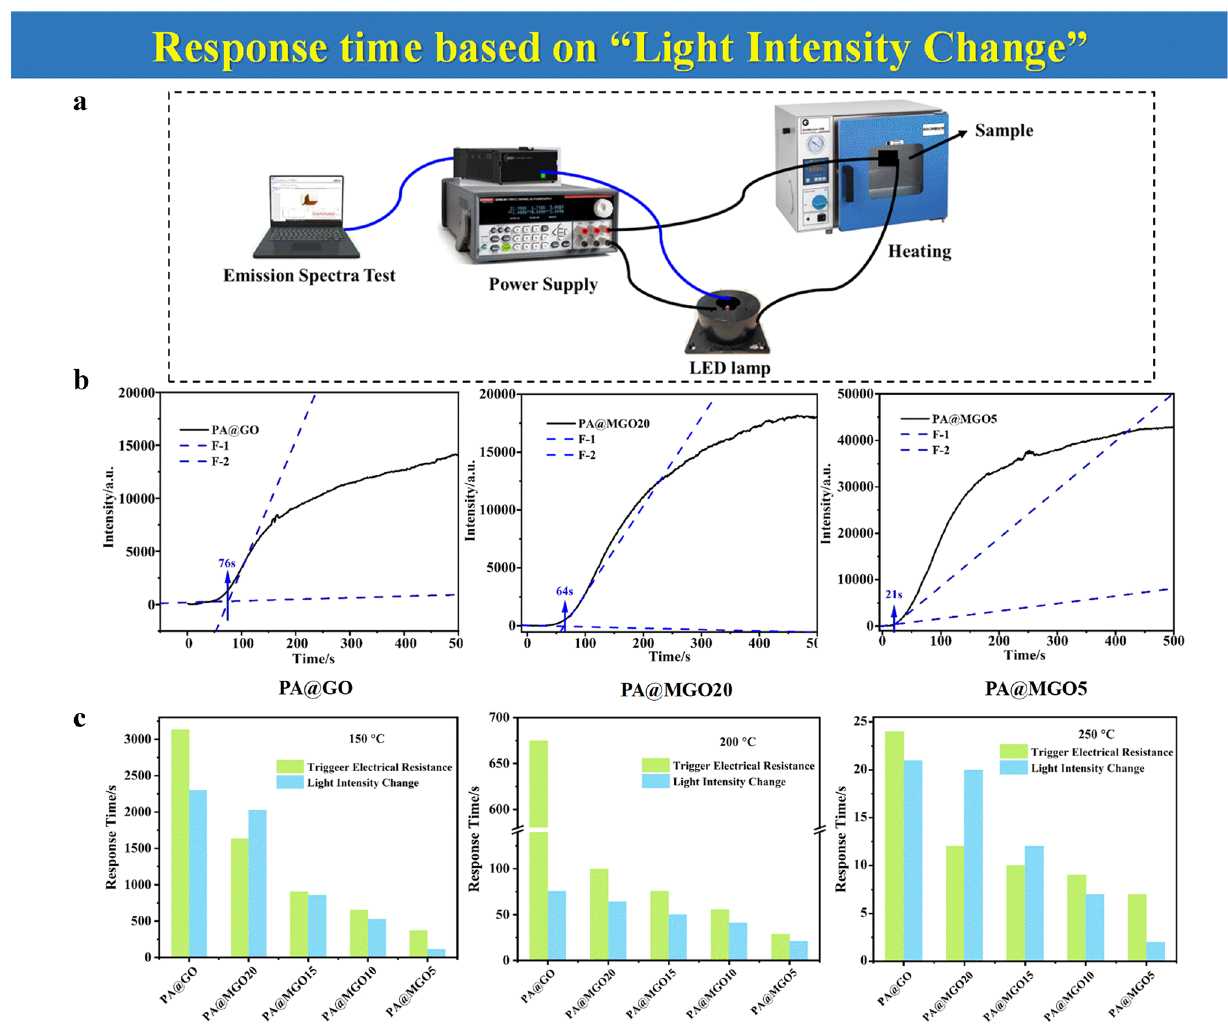
Fig. 4 a Schematic test process of light intensity change. b Doing tangent at lamp intensity change curves of fire‑warning samples at 200 °C for response time. c Comparison of response time based on calculation methodology between the “trigger electrical resistance” and the “light inten‑ sity change” at different test temperatures. Reproduced with permission from Ref. [66]. Copyright 2022